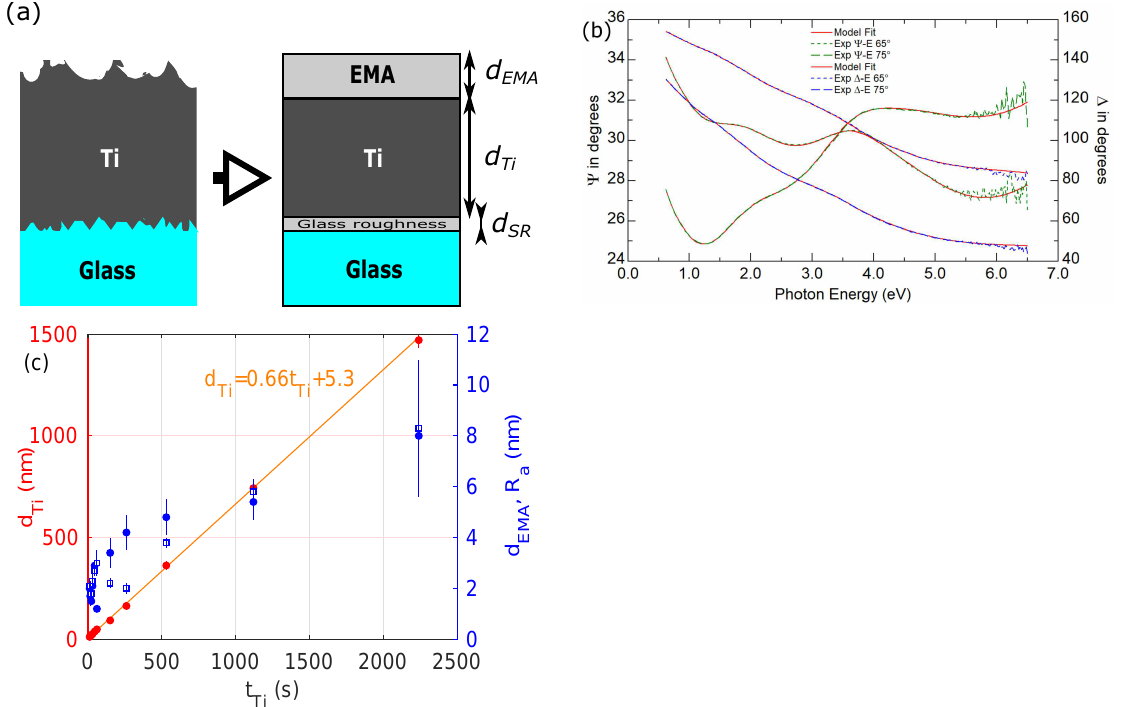
Figure 3. ( a ) A structure of the Ti coating deposited on the glass substrate and an optical model of a sample ( d EMA - the thickness of the rough layer, d Ti - the thickness of the titanium layer). ( b ) Experimental Ψ and ∆ azimuths for two angles of incidence (65 ◦ and 75 ◦ ) and their model fits for the Ti(363) sample. The fit was performed using P = 12 parameters ( χ 2 = 1.6). ( c ) Thicknesses of the titanium coating ( d Ti ) and the rough layer ( d EMA ; filled circles), as well as value of the R a parameter (open squares). The solid line represents the linear fit of d Ti versus t Ti dependence. EMA = Effective Medium